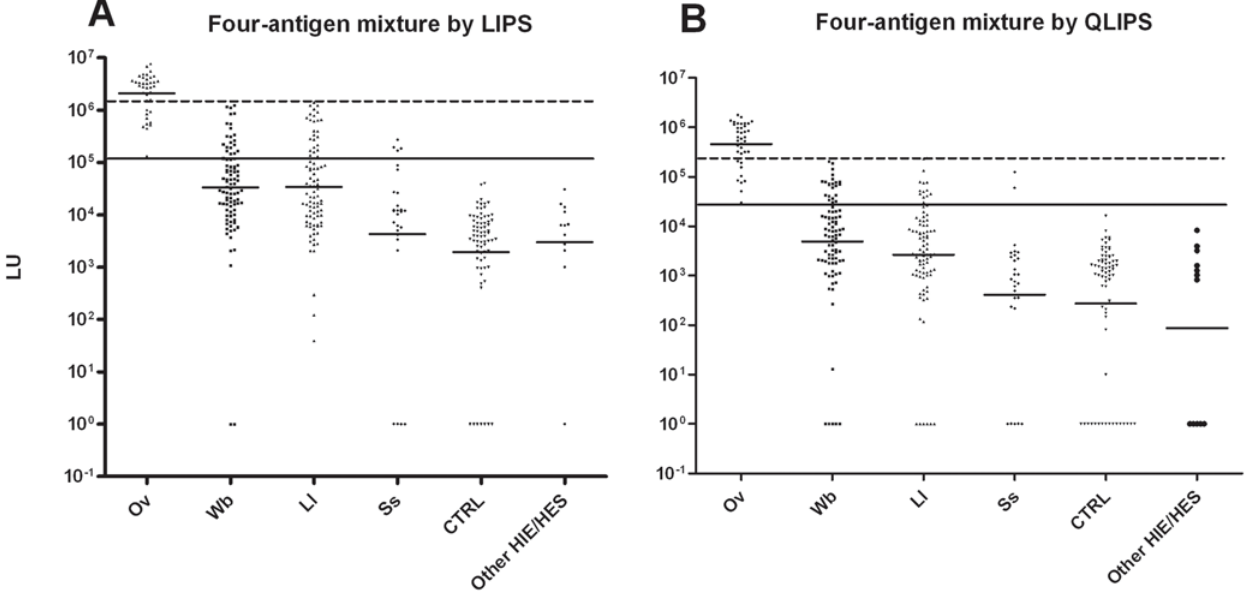
Figure 3. A four Ov antigen panel used in the standard 2 hour or QLIPS format shows 100% sensitivity and 100% specificity. Each symbol represents individual samples from the 38 Ov -infected, 90 Wb , 90 Ll , 27 Ss , 72 control uninfected samples and 12 other control patients. These LIPS tests were either evaluated as a mixture in the standard format (A) or with QLIPS (B). As shown, both tests showed 100% sensitivity and 100% specificity in distinguishing the uninfected from the Ov -infected sera. The diagnostic performance related to cross-reactivity with other filarial infections was also evaluated. As described in the text, the long solid line represents the cut-off level corresponding to 100% sensitivity, while the long stippled line corresponds to the cut-off for 100% specificity with sera from the Wb